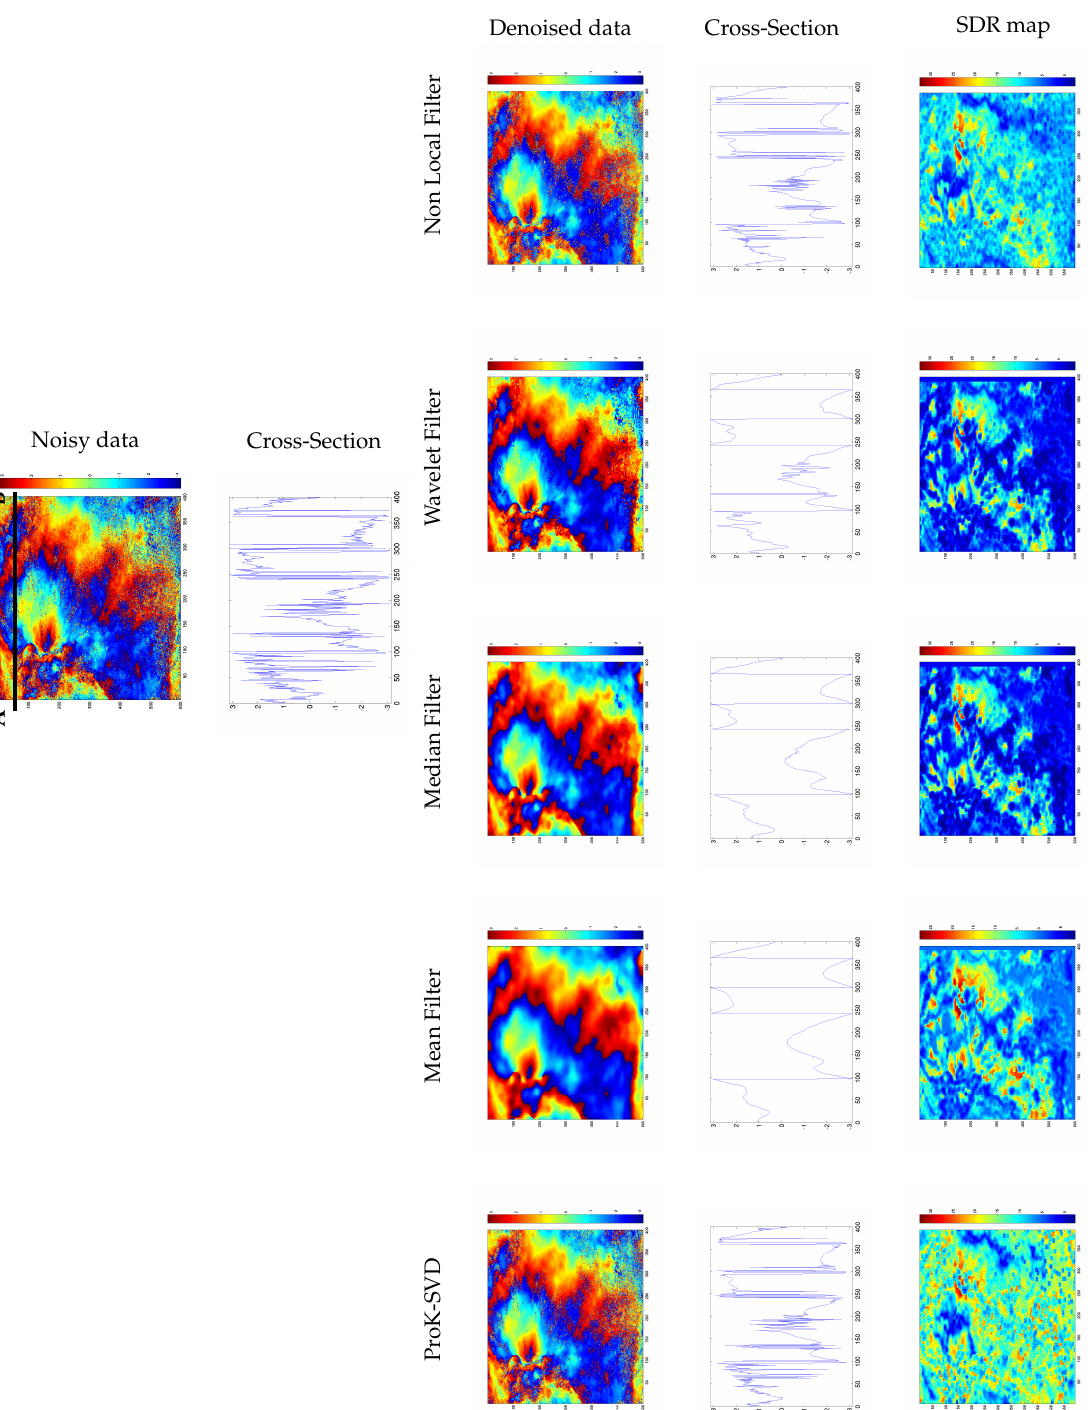
Figure 15. Comparison among ProK-SVD and several denoising techniques: at the top extracted 600 × 400 patch of the noisy interferogram with a phase cross section profile relevant to the A-B section. The third row shows the results of the denoised process using ProK-SVD, Mean filter, Median Filter, Wavelet Filter, and Non-Local filter. The fouth row displays the corresponding phase cross section profiles. The last row presents the SDR maps for each technique.